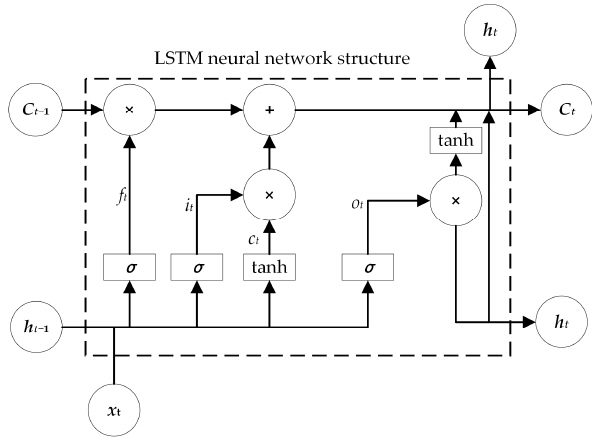
Figure 13. Basic unit structure of LSTM.